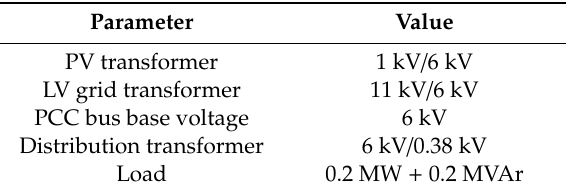
Table 1. Grid-integrated PV system parameter